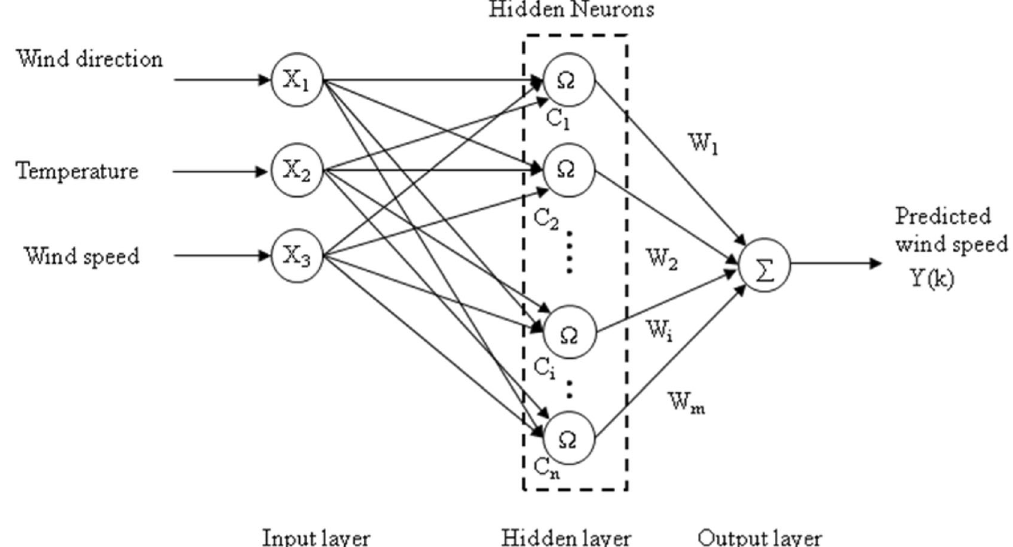
Fig. 1 Architecture of the proposed RRBFNN model